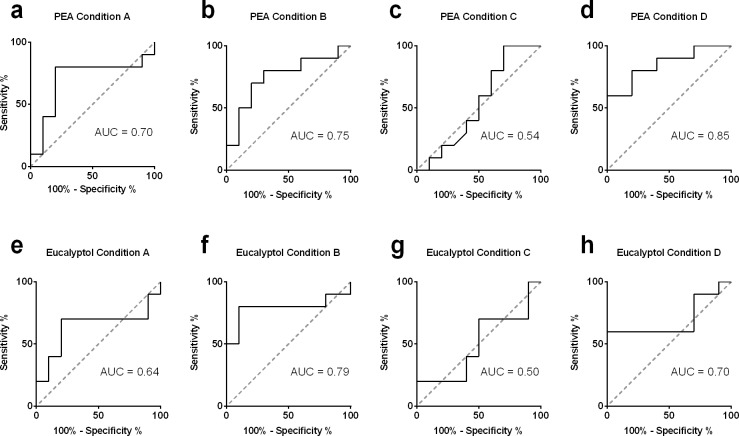
AUC in relation to different stimulus conditions.Displayed are the AUC calculated by ROC, a-d for olfactory and e-h for trigeminal stimulation for the four stimulus conditions. The largest AUC and therefore the highest sensitivity and specificity to distinguish between control and olfactory stimulation in terms of EEG-power change was obtained in condition D. The AUC analysis revealed only a significant AUC for trigeminal stimulation in condition B.